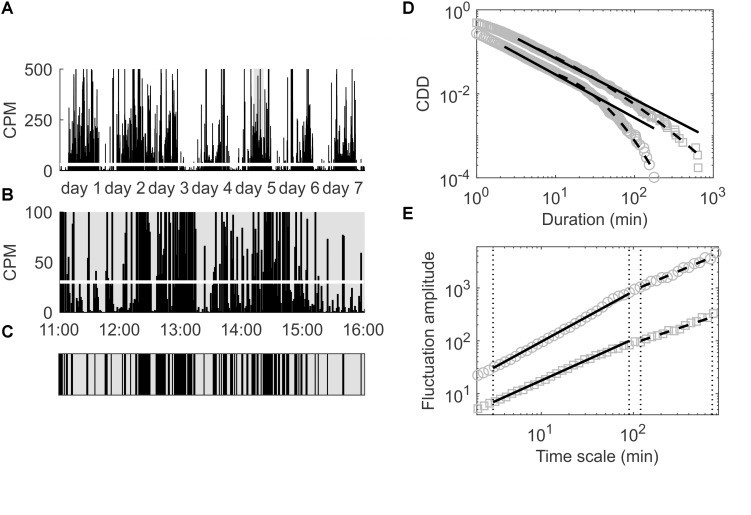
(A) Locomotor activity in CPM for the first seven consecutive days of a patient included in the present study; the overall mean activity is indicated by the thick white line. (B) Magnification of the time span of 11:00–16:00 at day 5 to illustrate the process of dichotomization of the data in order to analyze the empirical CDD of this patient. (C) Dichotomized data corresponding to the time span shown in (B); black areas represent durations during which the activity is above the overall average (thick white line in B), gray areas represent durations during which the activity is below that threshold. (D) Empirical CDD of the same patient (gray squares) and of another patient (gray circles) for comparison; distribution functions of best fitting power law (black solid lines) and best fitting lognormal distributions (black dashed lines) are also shown. (E) Fluctuation amplitudes for the same patients as in (D) versus time scale in minutes; short (below 1.5 h) and long (beyond 2 h) time ranges are indicated by vertical dotted lines and arrows; fitted power laws in those two time ranges are depicted using solid and dashed black lines, respectively.